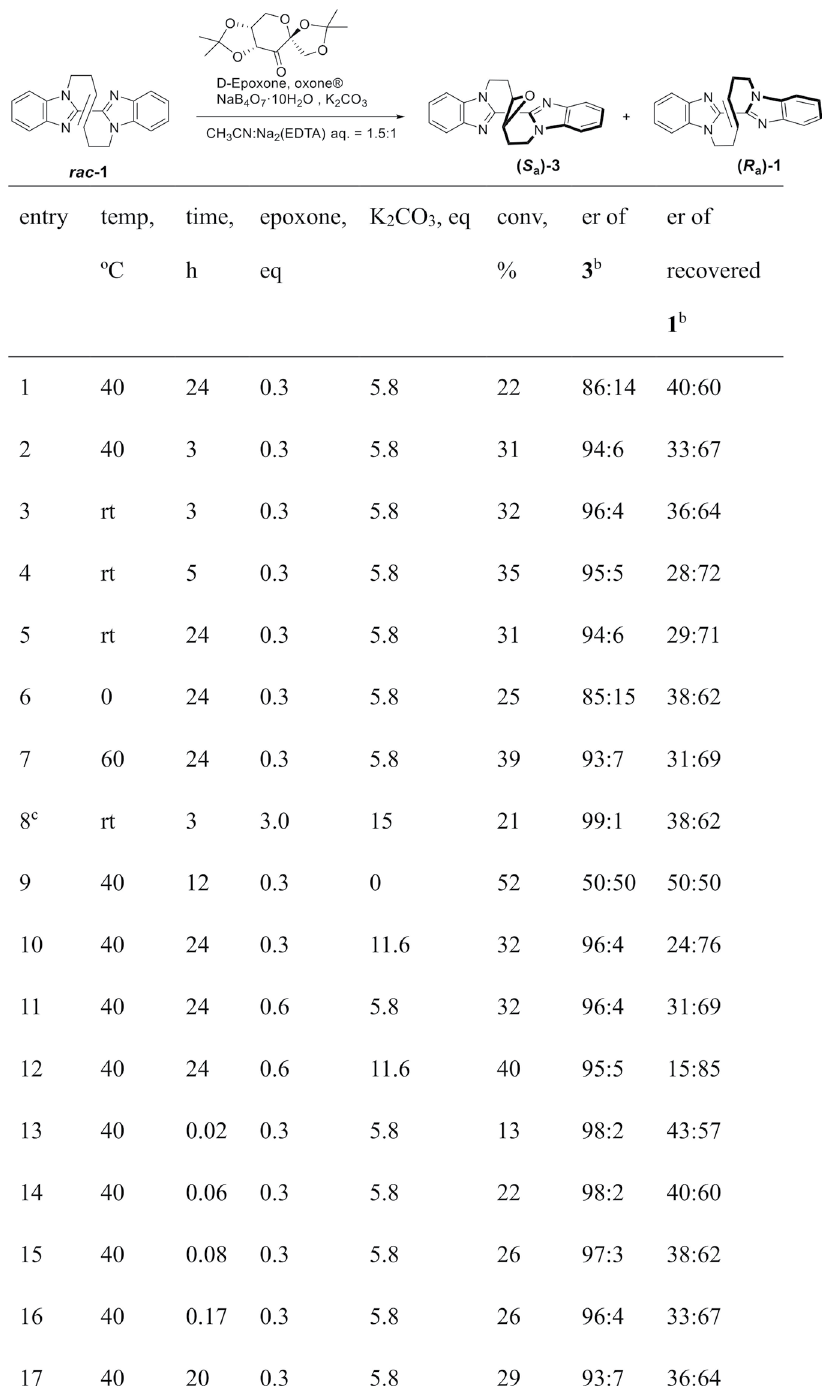
Figure 3. Table of the results on kinetic resolution of racemic bisbenzoimidzole 1 by Shi’s asymmetric epoxidation a . a The reaction was carried out with 0.1 mmol of rac - ( ± ) -1 with oxone ® (2.7 eq), n Bu 4 NHSO 4 (4 mol %), and NaB 4 O 7 (0.5 eq) in CH 3 CN/aq. Na 2 (edta) (1.5:1 v/v). b The enantiomeric ratio (er) was determined by HPLC analysis with chiral column (DAICEL Chiralpak IF). c The reaction was carried out with NaHCO 3 instead of K 2 CO 3 in CH 3 CN/Na 2 (edta)